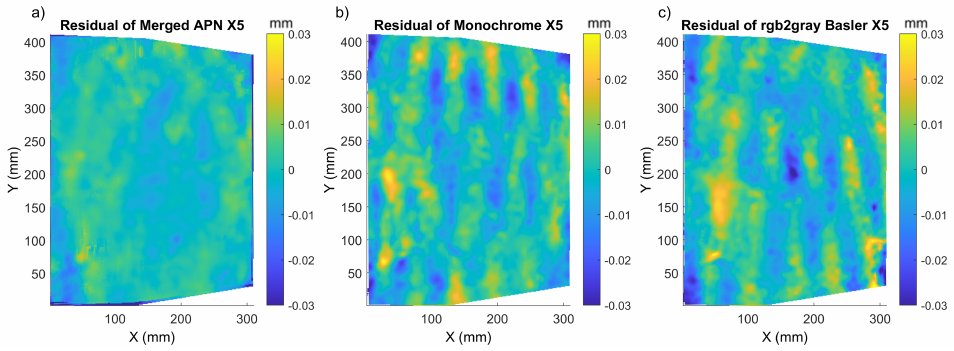
Figure 11. X5 residual displacement maps for Street corresponding to: ( a ) merged APN, ( b ) Monochrome and ( c ) Basler converted to monochrome.